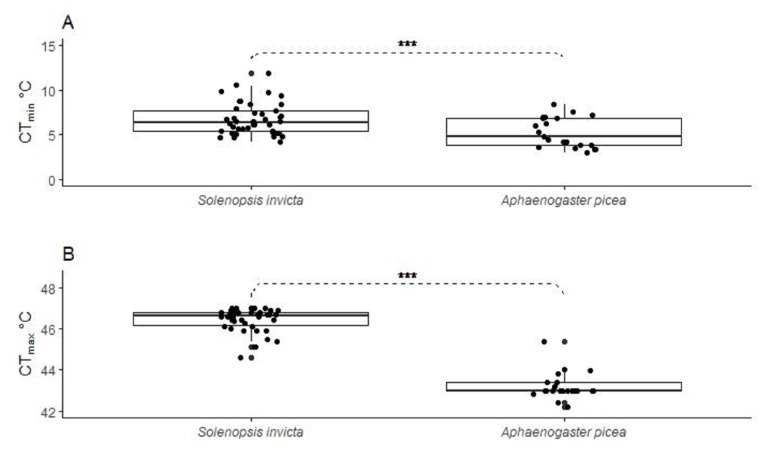
Boxplots showing Solenopsis invicta and Aphaenogaster picea cold (CTmin; 2A) and heat (CTmax; 2B) tolerance.Each boxplot includes the median (solid line) and upper and lower percentiles (25th and 75th) with error bars indicating outliers. Asterisks indicate significance of p-value < 0.001.